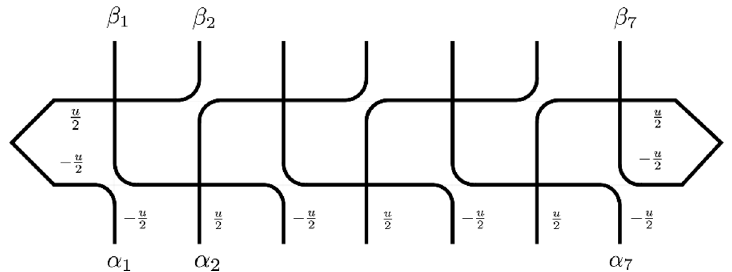
Figure 4 . The R -matrices with zero argument act as permutation operators depicted with avoiding lines. This transforms the double-row transfer matrix of the spin-chain geometry into the diagonal- to-diagonal transfer matrix of the boundary vertex